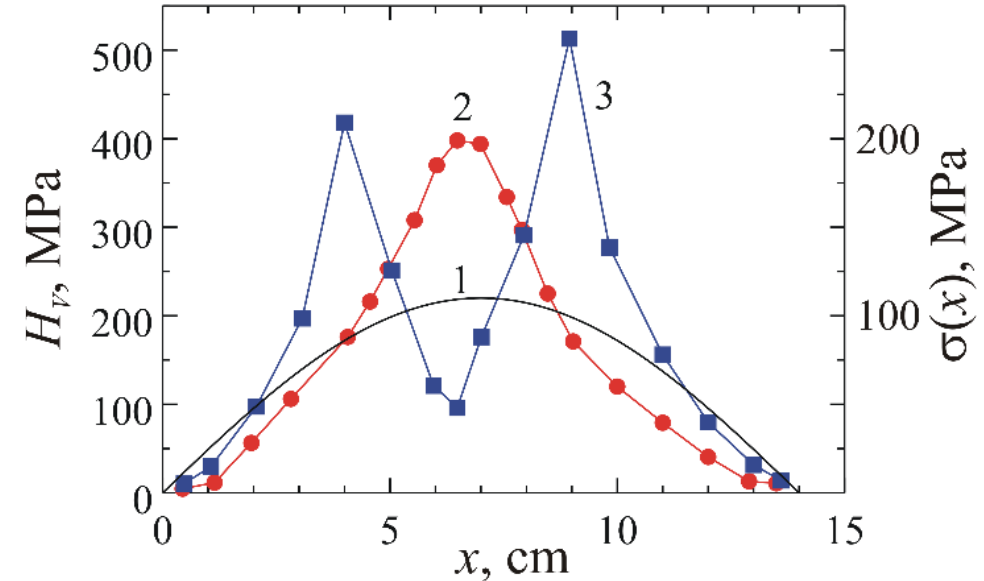
Figure 6. Distributions of the stress amplitude during UST (1) and microhardness values after UST with cooling (2) and without cooling (3) for time interval of t = 2 min. The graphs were plotted using the data presented in [24].